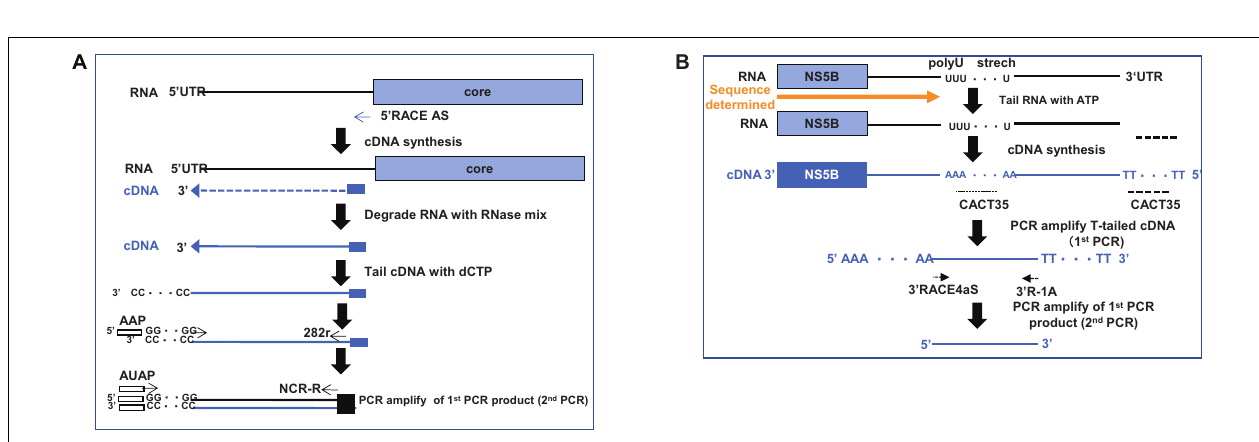
Frontiers in Microbiology |